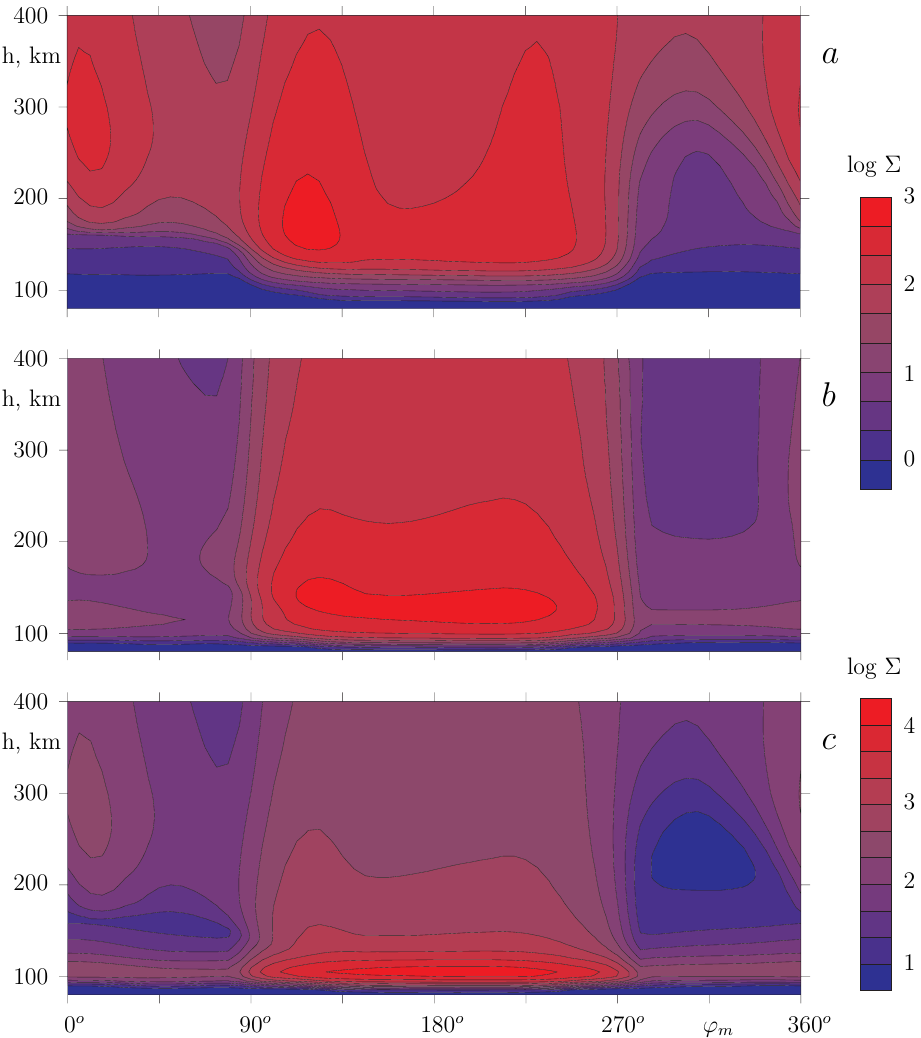
Fig. 6. Conductance distributions at the base surface near the geomagnetic equator for a short-term process. Panel (a) is for log 10 (6 P ) , panel (b) is for log 10 (6 H ) , panel (c) is for log 10 (6 C ) , where conductances in S units are used. The abscissa is the geomagnetic longitude ϕ m and the ordinate z is the height at which the magnetic field line crosses the base surface. The top color scale is for 6 P ,6 H . The bottom √ 10 ’ 2 times. The contours 6 P < 1 S,6 H < 1 S and 6 C < 10 S are color scale is for 6 C . The values at the neighbor plotted contours differ 3 not plotted and a common color is used for these small values of 6